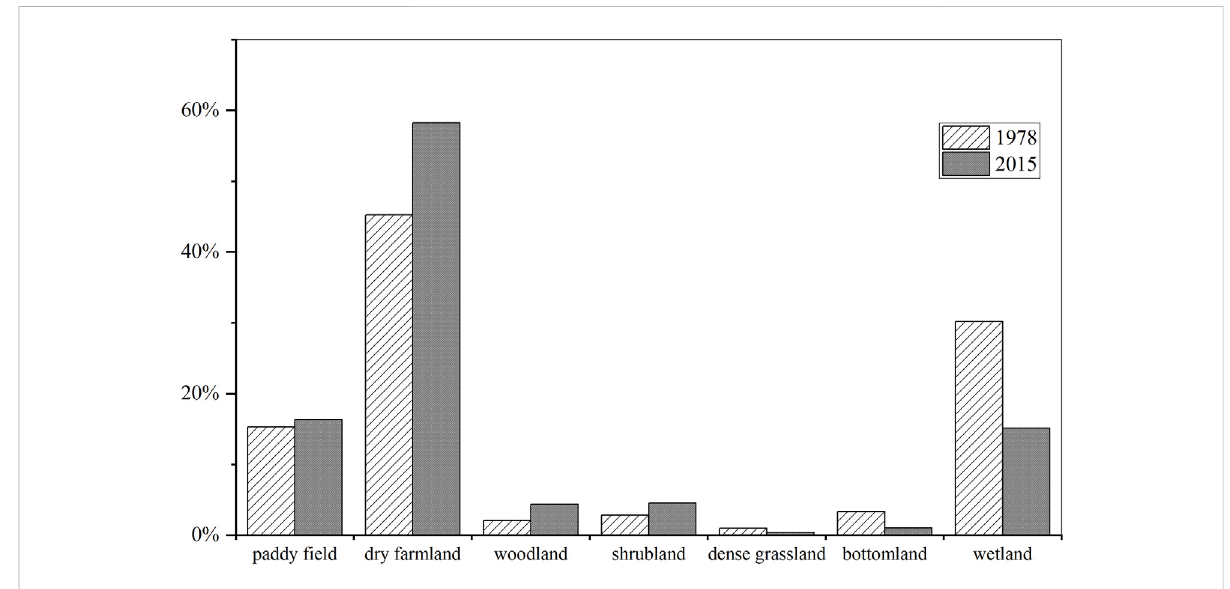
FIGURE 11 Map of the land-use area change in the Lalin River Estuary Wetland Nature